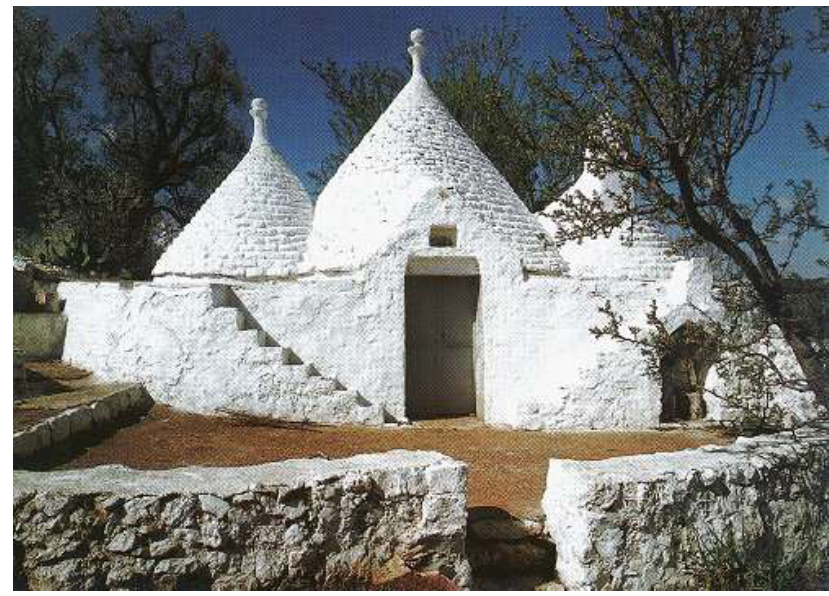
Figure 4. Whitewash complex trullo.